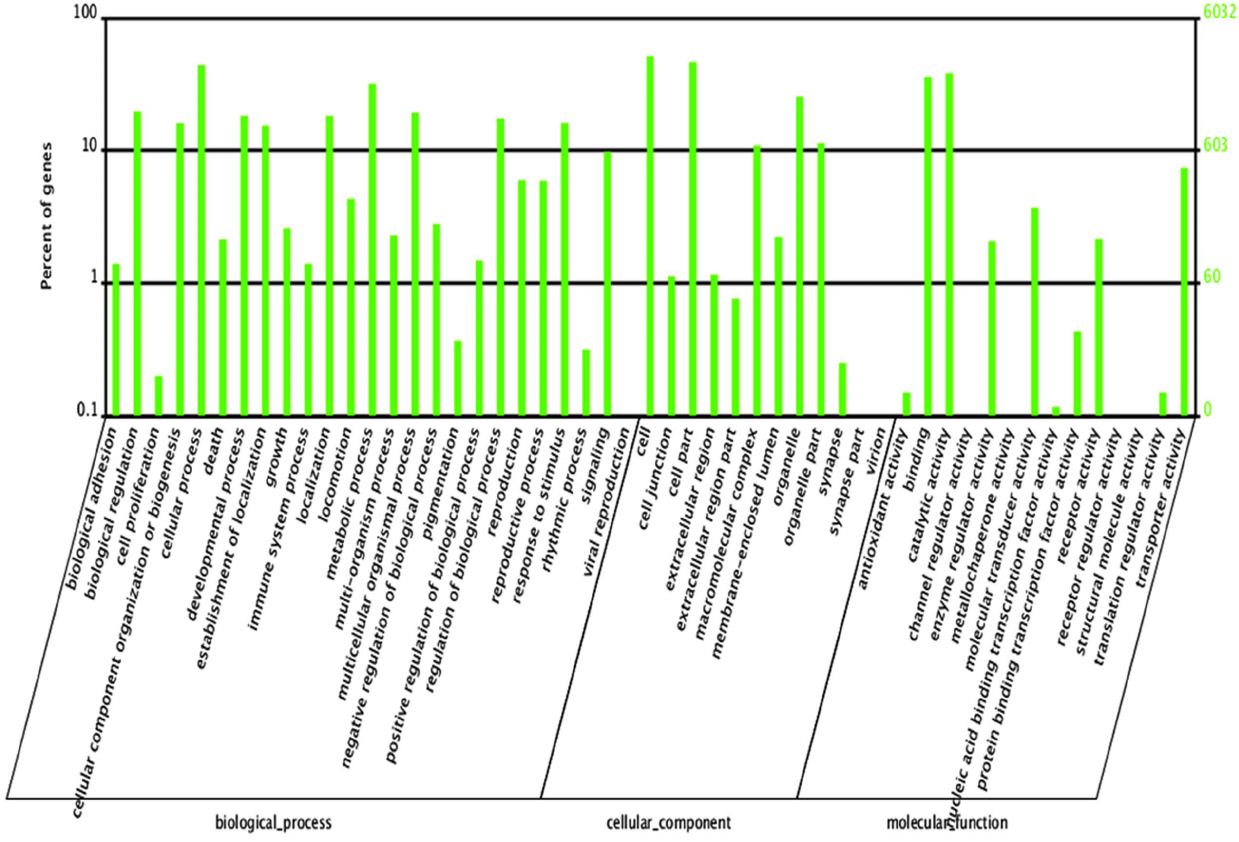
Figure 1. GO annotations of non-redundant consensus sequences. Best hits were aligned to the GO database, and 6032 transcripts were assigned to at least one GO term. Most consensus sequences were grouped into three major functional categories, namely biological process, cellular component, and molecular function.